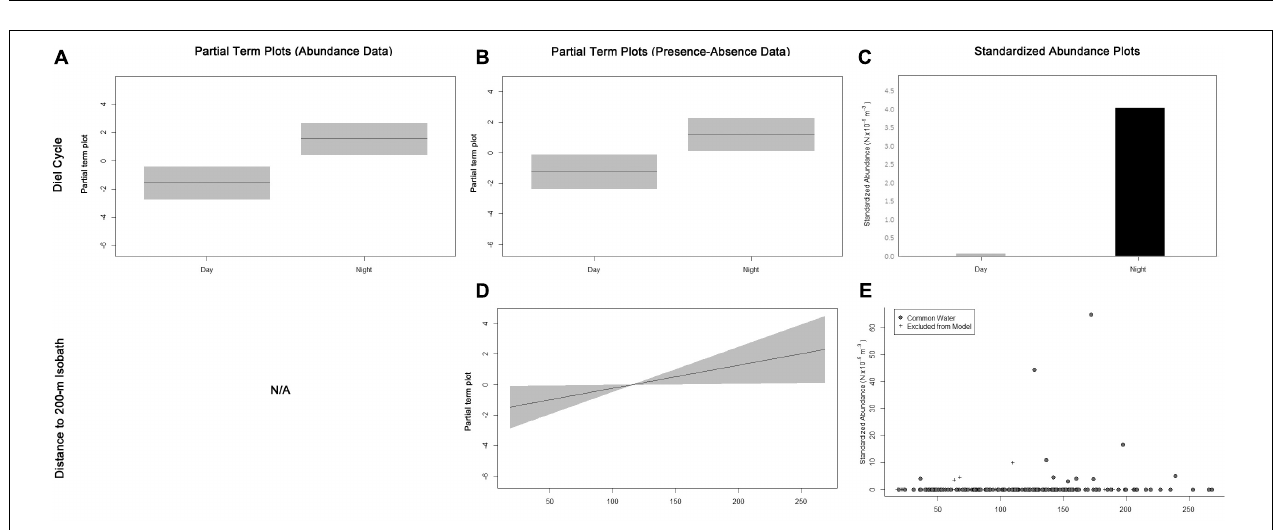
FIGURE 4 | Term plots for the best-fitting models for Thunnus atlanticus data fitted to the abundance data (A,D,G) and presence–absence data (B,E) . Standardized abundance plots (C,F,H) are also presented for all important and marginally important variables. Data that had to be excluded from the model due to missing MOCNESS sensor data are indicated by crosses.